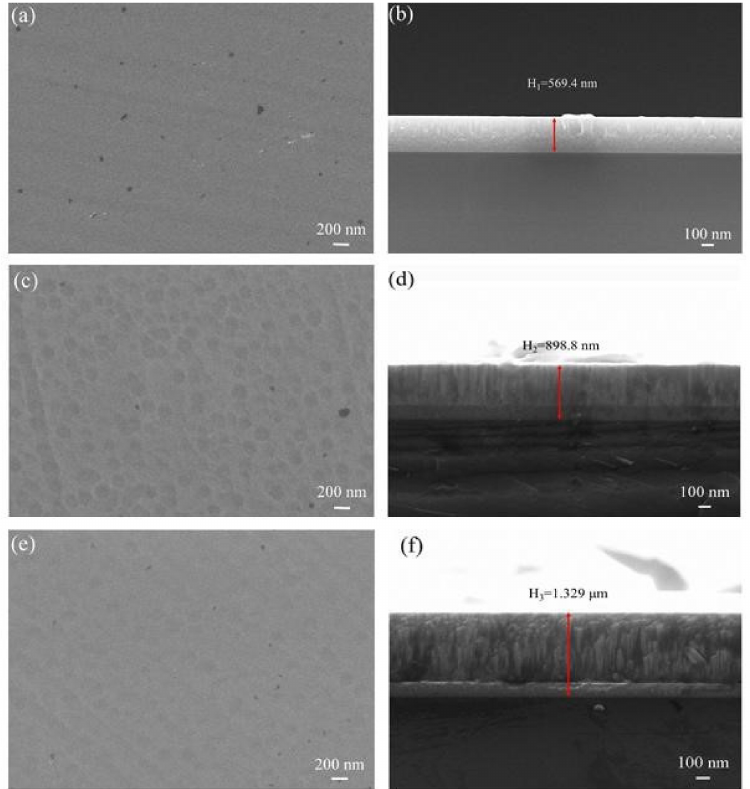
Figure 3. The FE-SEM electron microscope image of the microscopic and cross-section of TiMoN coatings: ( a , b ) TiMoN-2A, ( c , d ) TiMoN-4A, ( e , f )